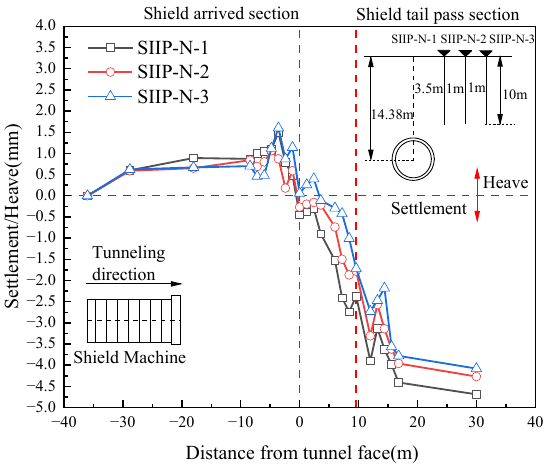
Figure 9. Time history curve of surface vertical displacement of section B.